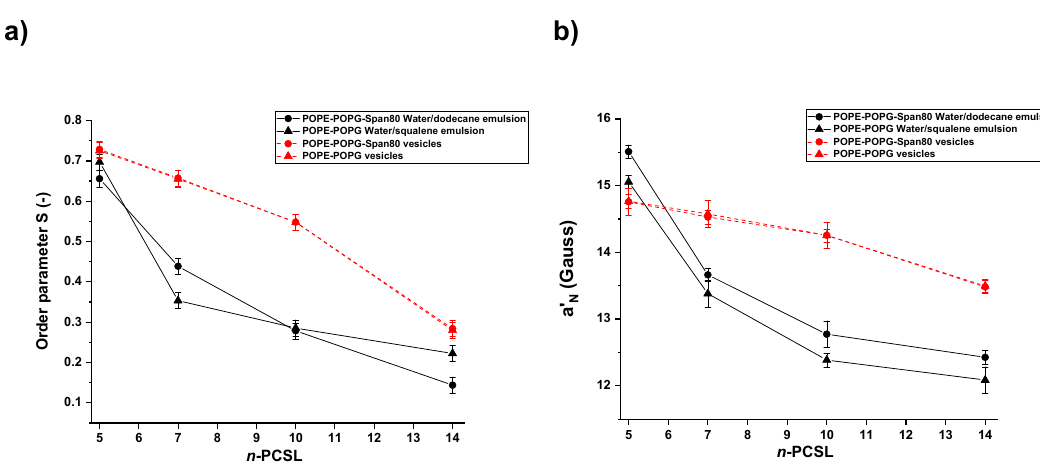
Figure 4. Dependence on spin-label position, n, of the order parameter, S ( a ), and of the micropolarity index a’ N ( b ), of the n-PCSL phosphatidylcholine spin labels in: POPE-POPG vesicles ( ▲ , dotted red line); POPE-POPG-Span 80 vesicles ( ● , dotted red line); POPE-POPG water/squalene emulsion ( ▲ , solid black line); POPE-POPG-Span 80 water/dodecane emulsion ( ● , solid black line).